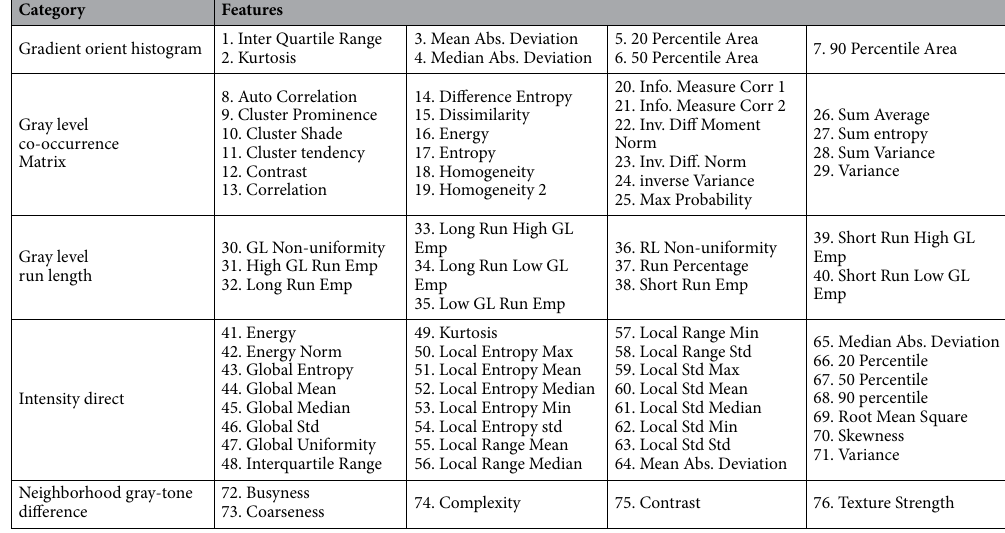
Table 9. The examined radiomics features extracted from delineated ROIs on MR